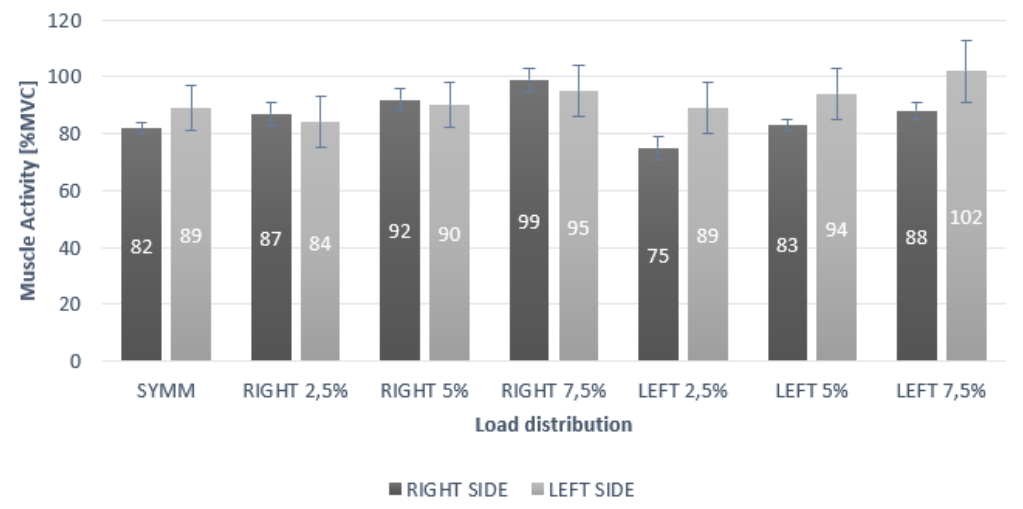
Figure 2. Muscle activity of pectoralis major under different loading positions.